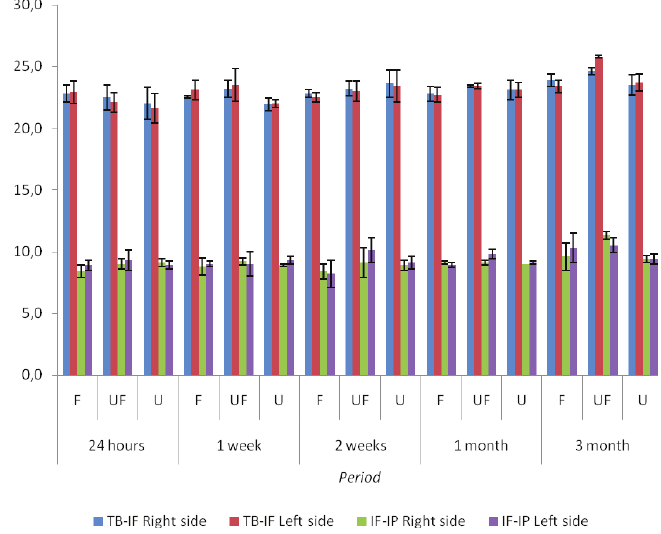
FIGURE 4 – Mean values (mm) of the distances found on the maxilla of all the groups according to the experimental period ( TB = tympanic bulla, IF = infraorbital foramen, IP = incisal point of the maxilla, F = fracture group, UF = undernourished fracture group, U = undernourished group).